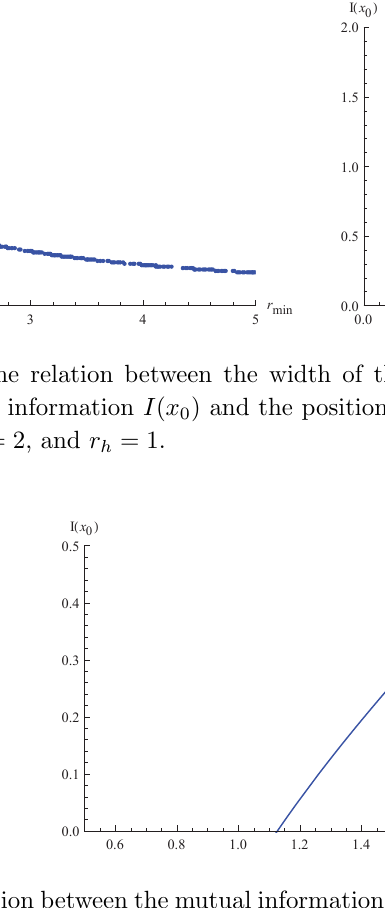
Figure 3 . The relation between the mutual information I ( x 0 ) and width of the strip x 0 for m = 0 : 6, Q = 2, and r h =